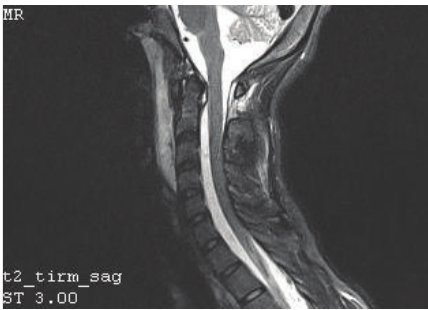
Figure 3: Sagittal MR reconstruction image shows spinal cord after trauma.